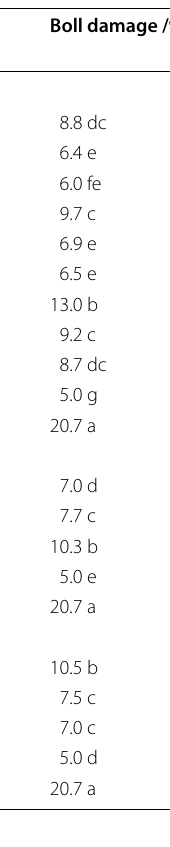
Table 3 Effect of EPN strains at three application rates on Earias vittella population, square and boll damage of cotton—Field experiment